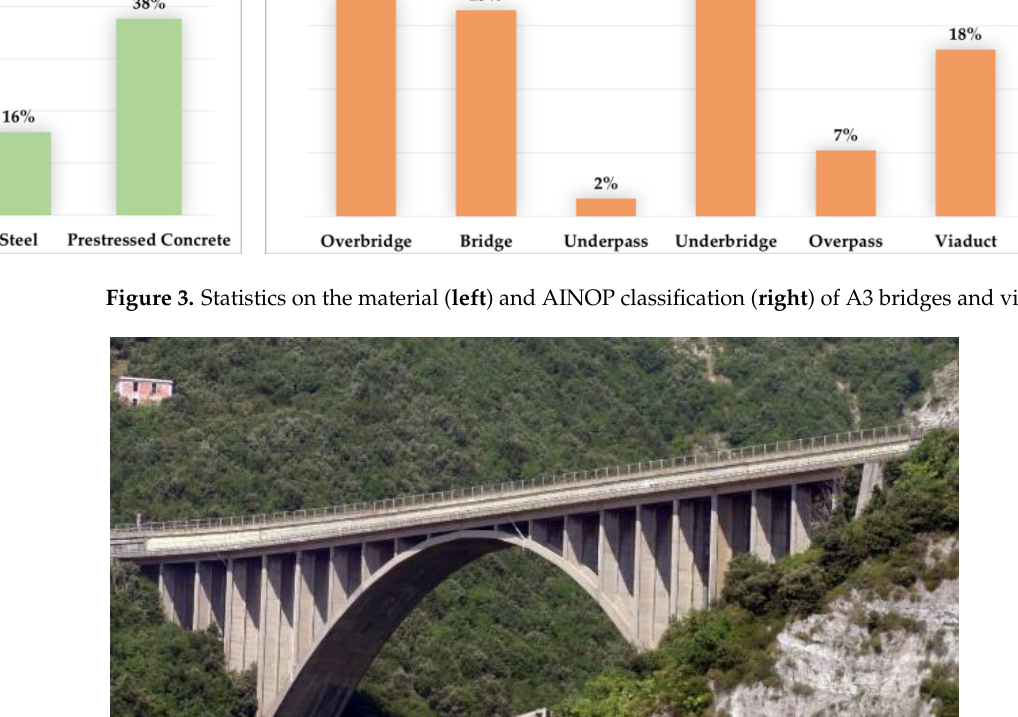
Figure 4. Arch bridge located near Salerno (Southern Italy) .